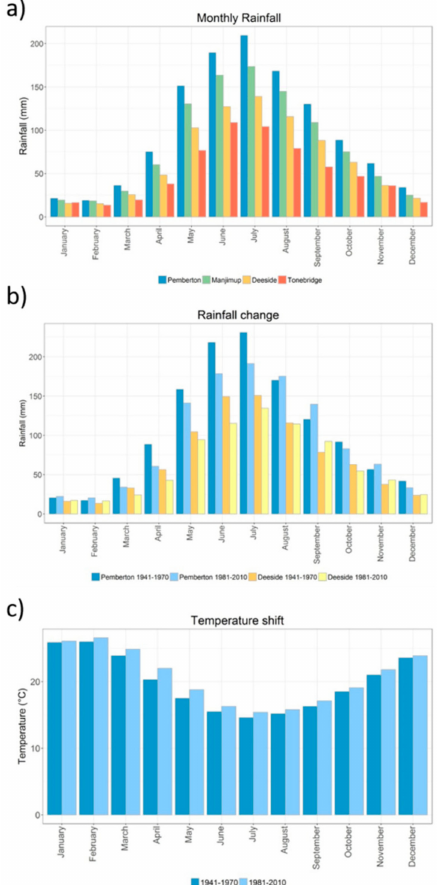
Figure 3. ( a ) Average monthly rainfall at four weather stations across the Warren River catchment (1941–2015), for locations see Figure 2; ( b ) change in rainfall at two weather stations, Pemberton (blue) and Deeside (yellow), from 1941–1970 in darker color and 1981–2010 in lighter color; and ( c ) change in monthly mean maximum temperature at Pemberton from 1941–1970 in darker color and 1981–2010 in lighter color. Adapted from